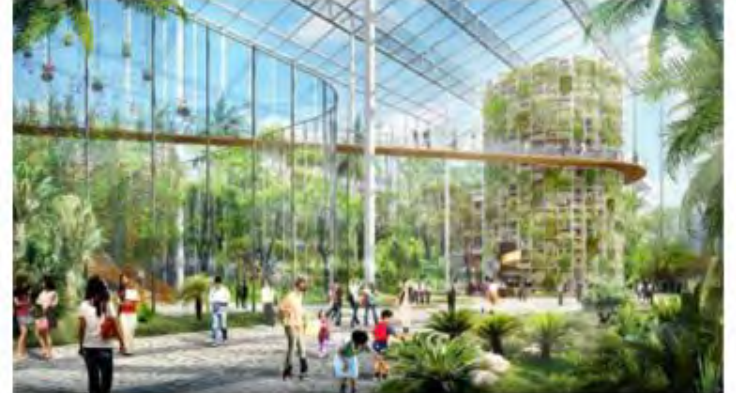
Figure 9. Shanghai is planning a massive 100-hectare vertical farm to feed 24 million people (”Inhabitat”,